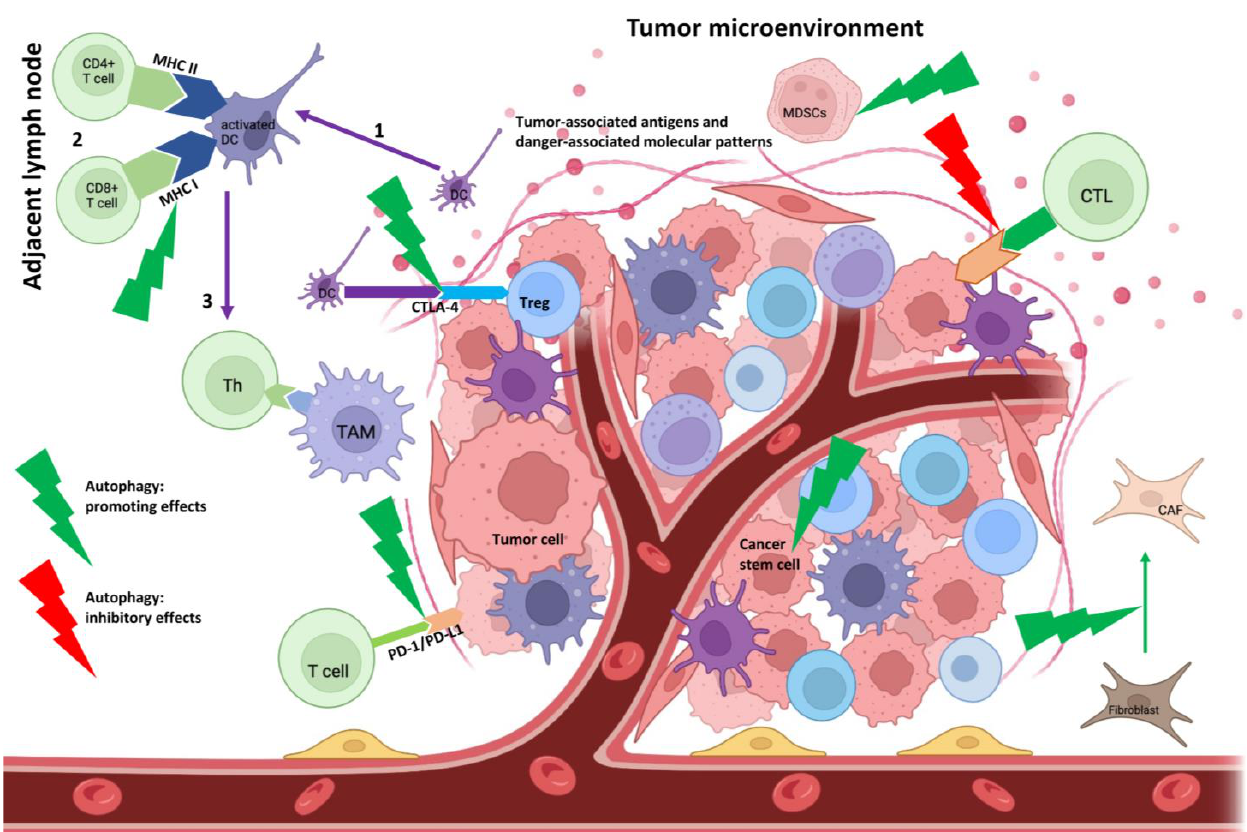
Figure 3. Immunobiological impact of autophagy in TME. Tumor-associated antigens formed in tumor cells and DAMPs from dying tumor cells are taken up by DCs (1). During migration and activation of DCs, antigen presentation to naïve CD4+ and CD8+ T cells occurs through MHC and costimulatory molecules (2). Autophagy can enhance the expression of MHC I molecules. Following antigen recognition, T cells differentiate into CTLs and effector Th cells. The differentiated T cells migrate into TME (3), where autophagy may promote increased PD-L1 and CTLA-4 expression and decreased MHC I expression on malignant cells, thereby inhibiting the effectiveness of cytotoxic T cells. In addition, autophagy promotes the formation and survival of MDSCs and CSCs and may enhance the conversion of fibroblasts into CAFs. Together, these effects may be beneficial for tumor development. The figure was in part created by using BioRender.com, accessed on 4 th of March, 2023.